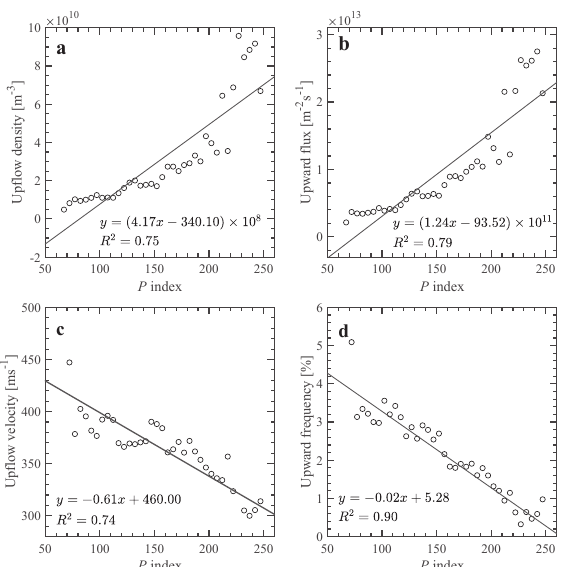
Figure 6. Scatter points of upflow parameters versus P index: (a) ion upflow density, (b) ion upflow flux, (c) ion upward drift, and (d) upflow occurrence frequency. The curves show the linear fitting results.